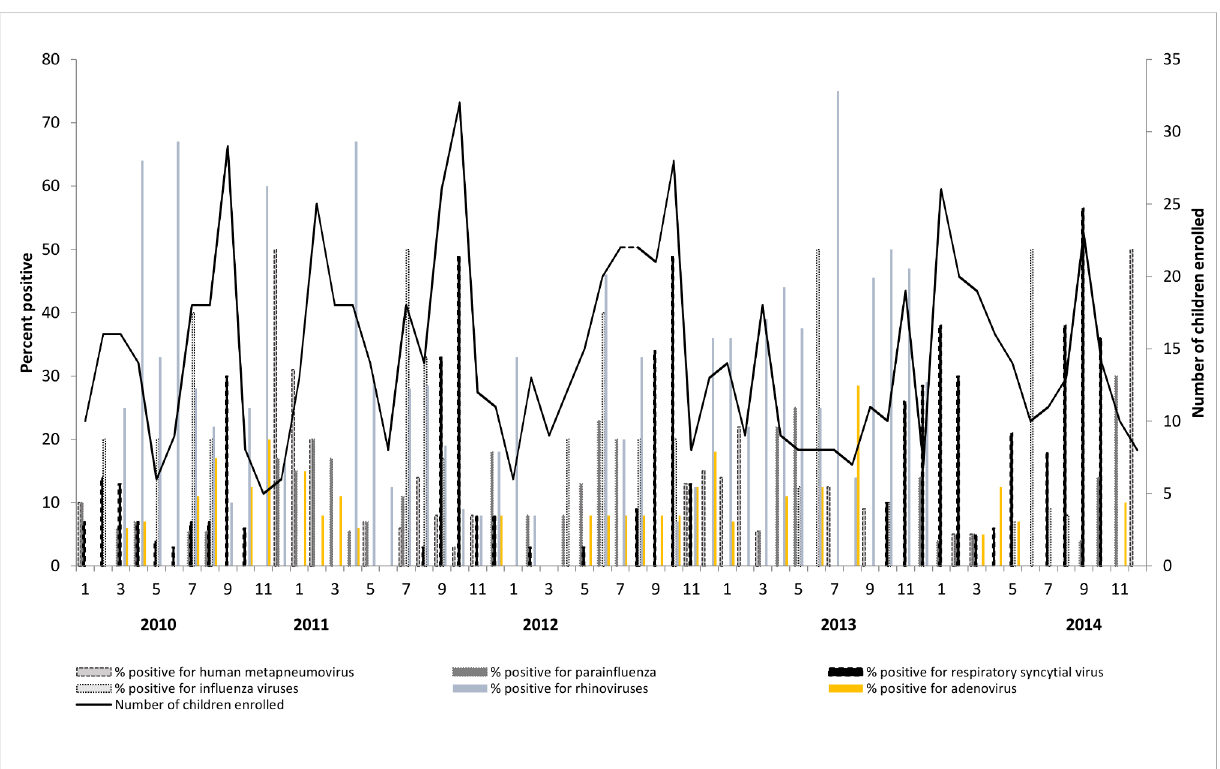
Fig 3. Monthly distribution of total number of enrolled hospitalized children with respiratory symptoms andproportion of children with respiratory symptoms positive for respiratory syncytial virus, human metapneumovirus, parainfluenza, influenza, adenovirus and rhinovirus infection in the four surveillance hospitals, Bangladesh, 2010 –